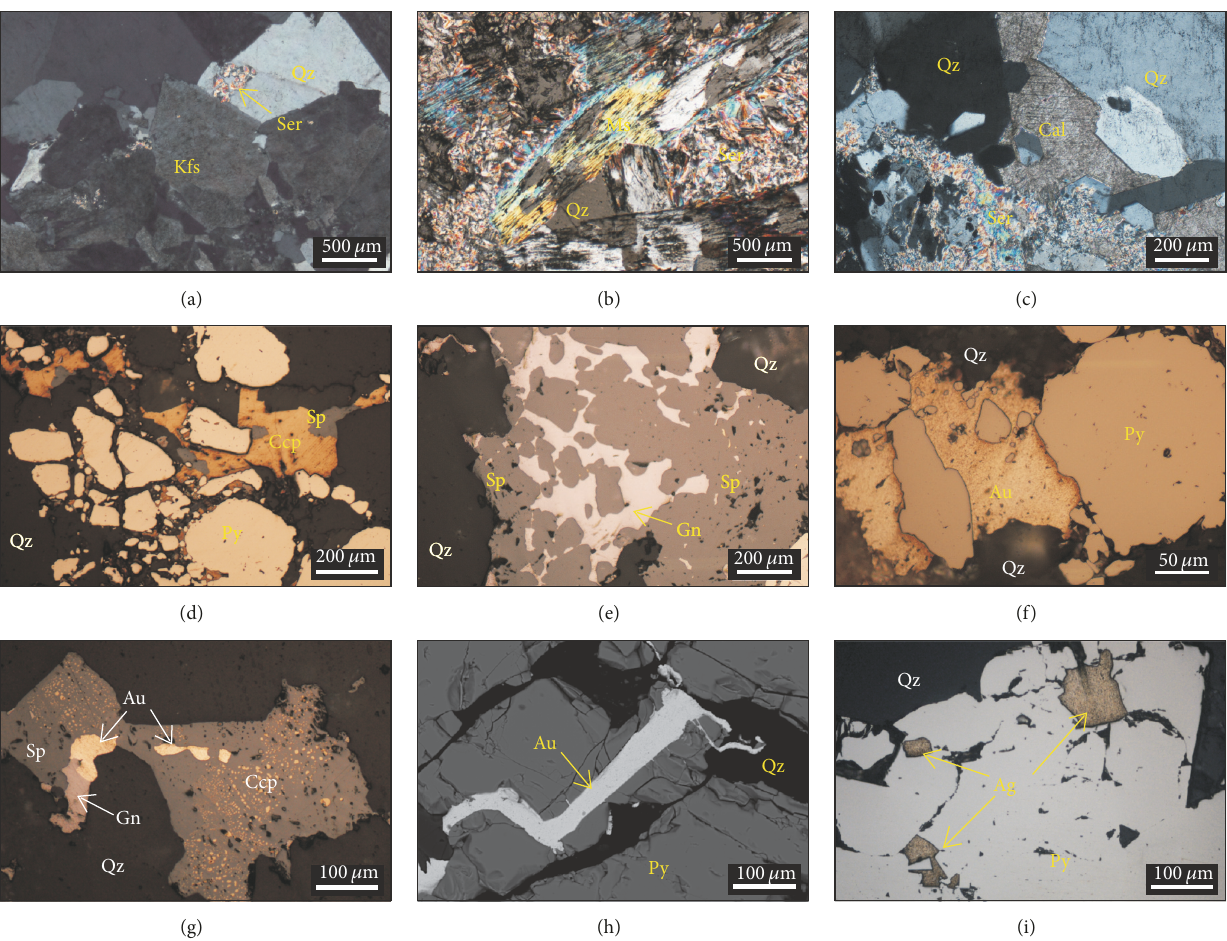
Figure 4: Photomicrographs under transmitted light (a–c), reflected light (d–g, i), and back-scattered electronic images (h) showing the minerals and alteration assemblages in the Liyuan gold deposit. (a) K-feldspar occurring as an early alteration product intergrowth with quartz and sericite. (b) Typical sericite alteration consisting of sericite and muscovite. (c) Quartz-calcite vein with quartz-sericite alteration. (d) Middle stage chalcopyrite and sphalerite replacing the early stage deformed pyrite. (e) Middle stage sphalerite replaced by galena. (f) Ag- bearing native gold replacing the pyrite. (g) Ag-bearing native gold occurring as interstitial fillings between sphalerite, galena, and quartz or as irregular in sphalerite. (h) Ag-bearing native gold filling the microfracture of the pyrite. (i) Irregular Au-bearing native silver grains in pyrite. Ser: “sericite”; Ms: “muscovite”; Qz: “quartz”; Cal: “calcite”; Py: pyrite; Ccp: “chalcopyrite”; Sp: “sphalerite”; Gn: “galena”; Au: “Ag-bearing native gold”; Ag: “Au-bearing native